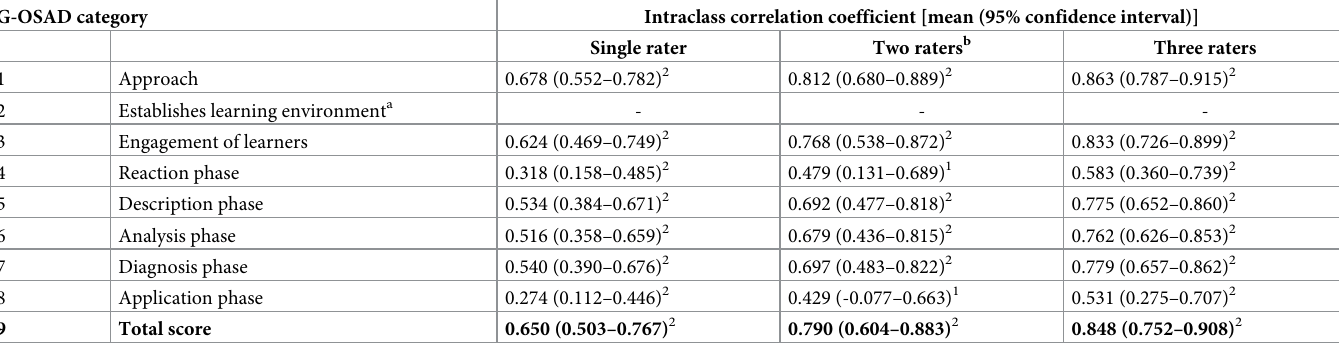
Table 2. Interrater reliability (as intraclass correlation coefficient) for the single and average ratings for each category across all of the debriefings (N = 57).